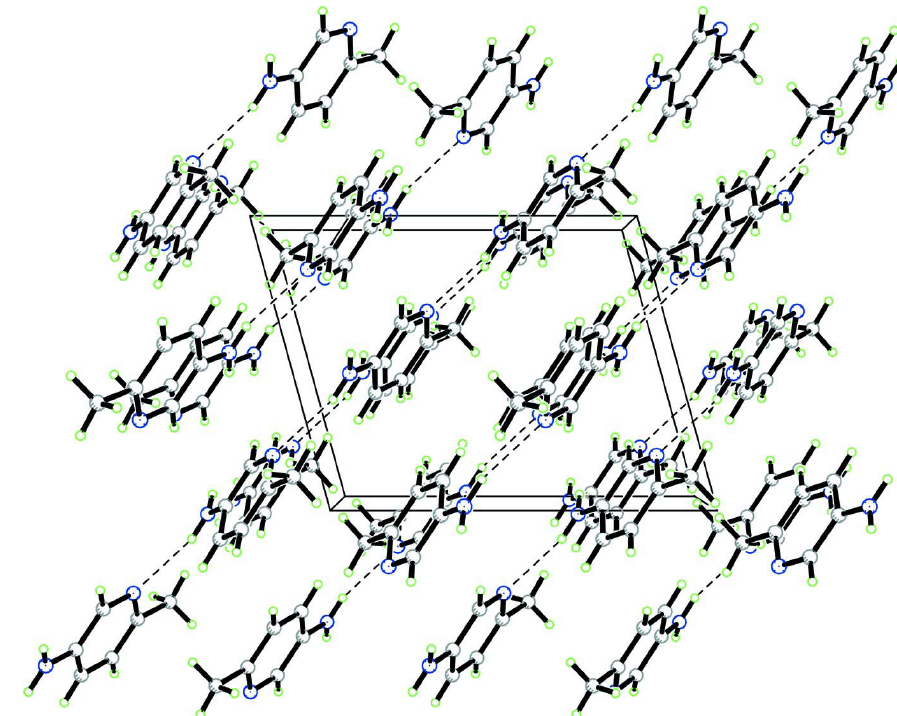
Figure 2 A partial packing diagram of the title compound. Hydrogen bonds are shown as dashed